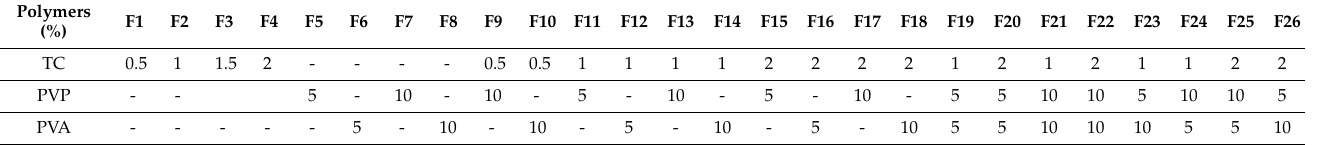
Table 1. Composition of dissolvable microneedle patches